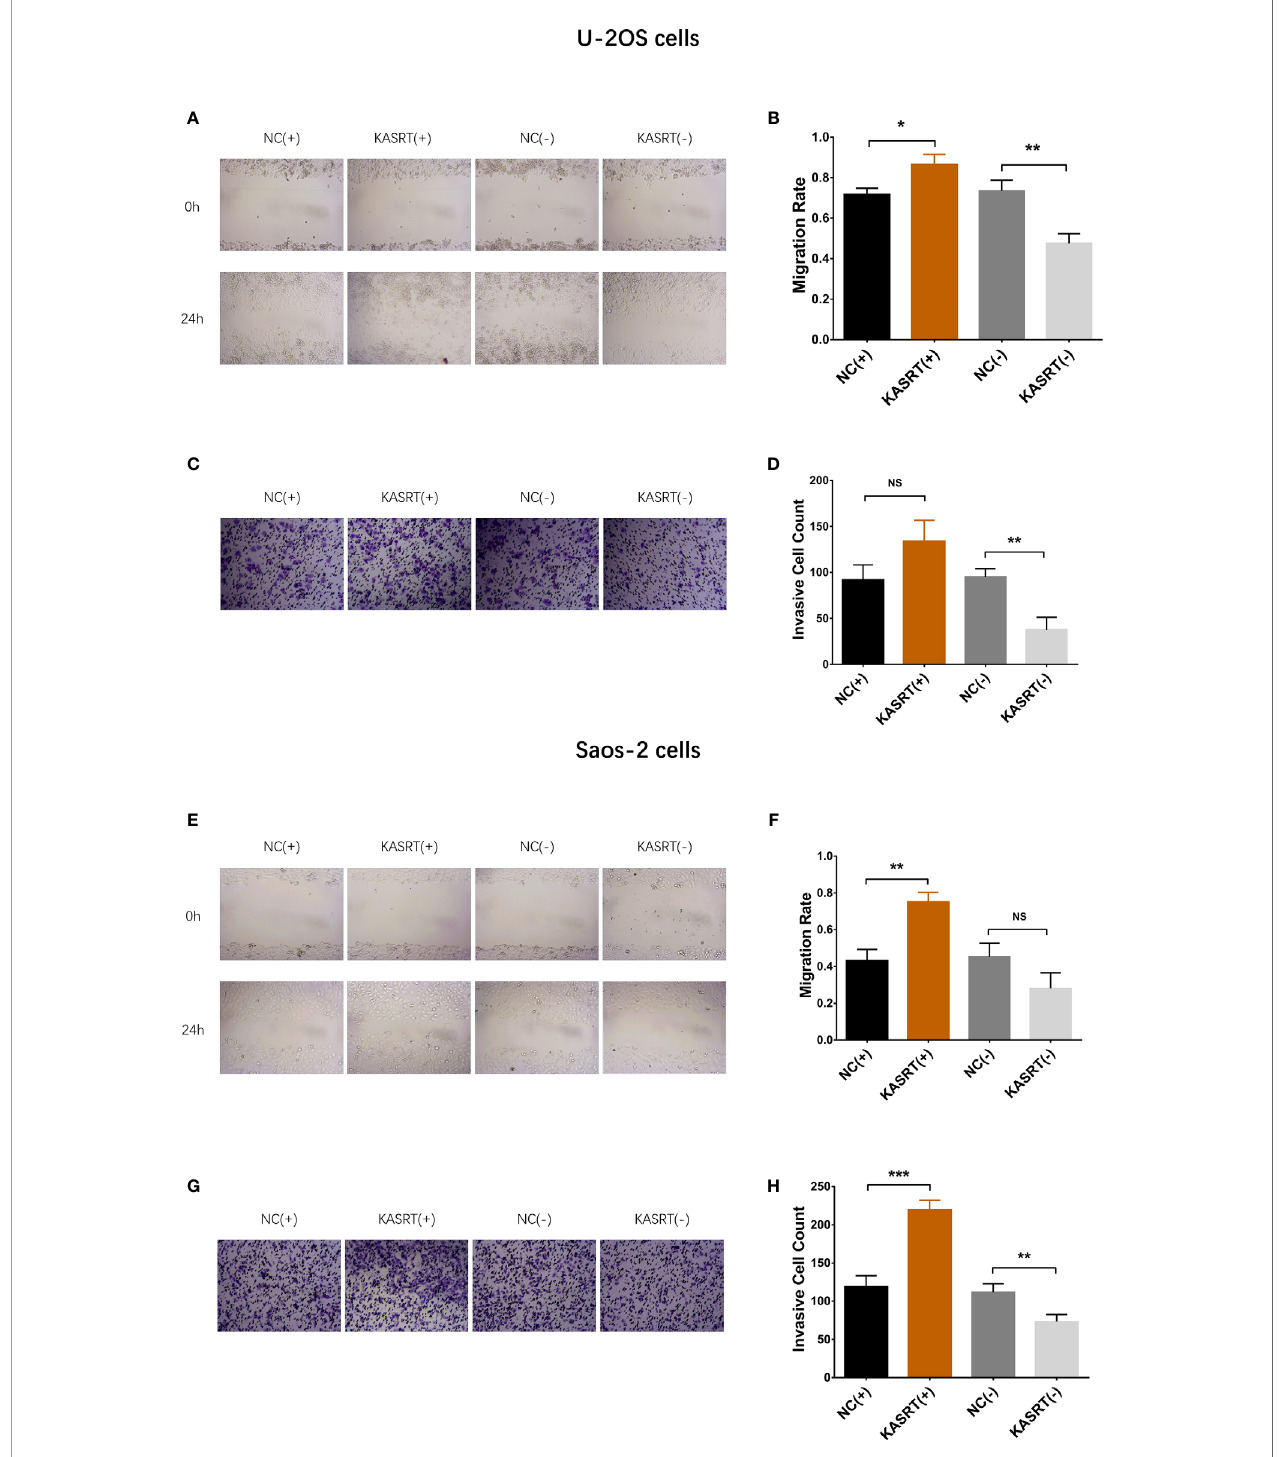
FIGURE 3 | Cell migration and invasion. Cell migration (A, B) and invasion (C, D) among groups of U-2OS cells. Cell migration (E, F) and invasion (G, H) among the groups of Saos-2 cells. *P < 0.05, **P < 0.01, ***P < 0.001, NS, Not signi fi cance (P >